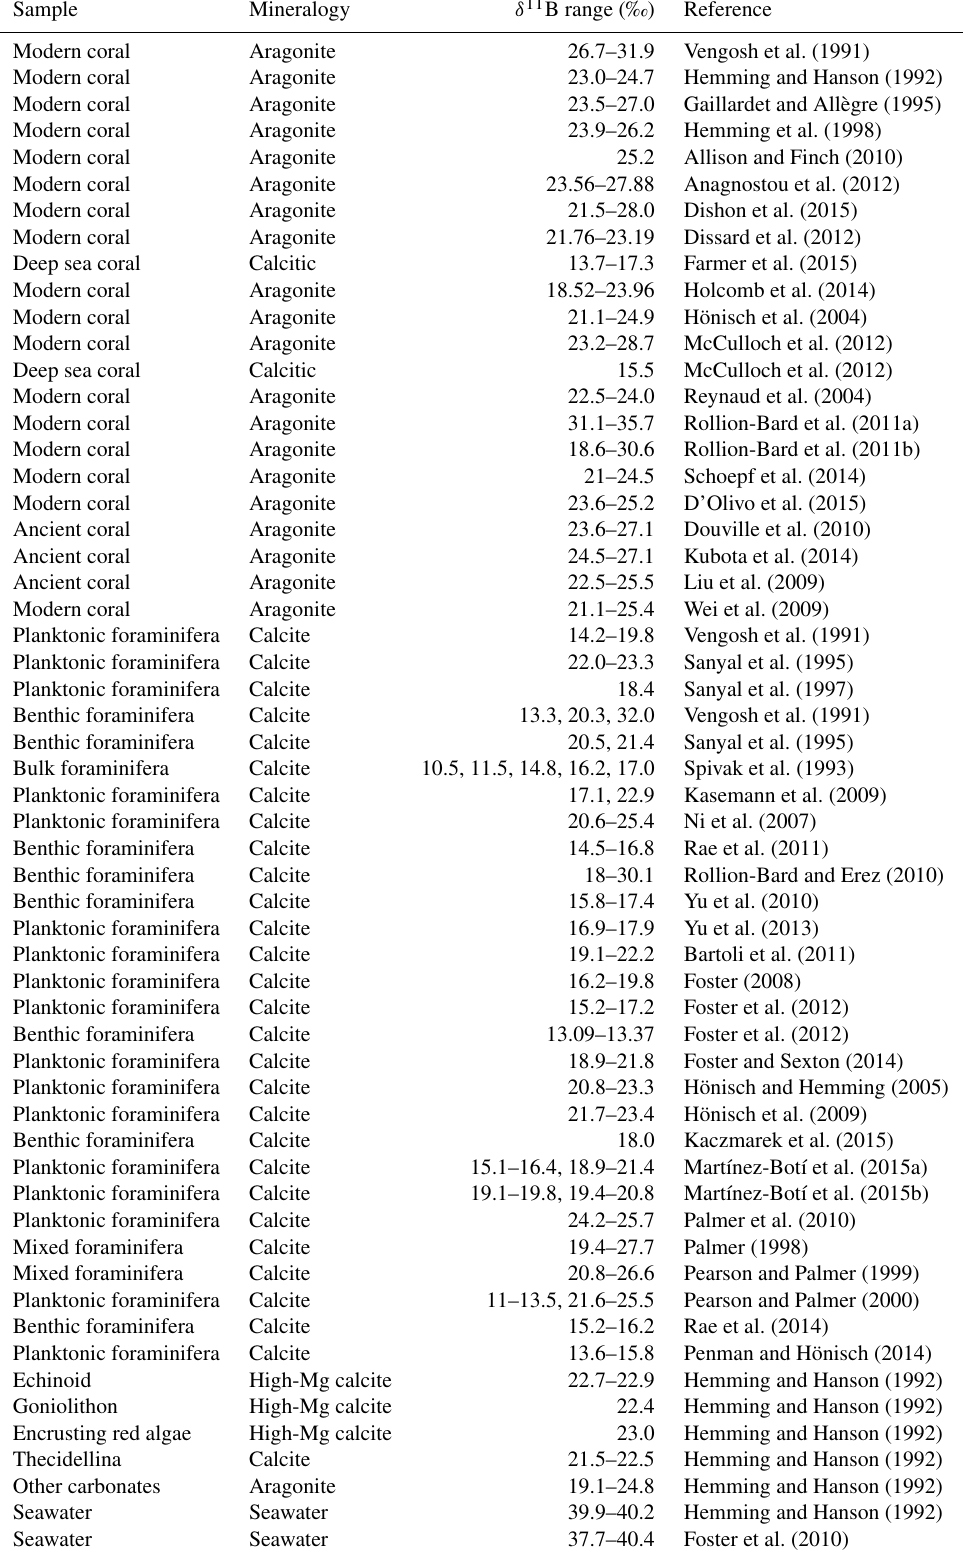
Table 5. Previously published δ 11 B analyses of biogenic marine carbonates and seawater